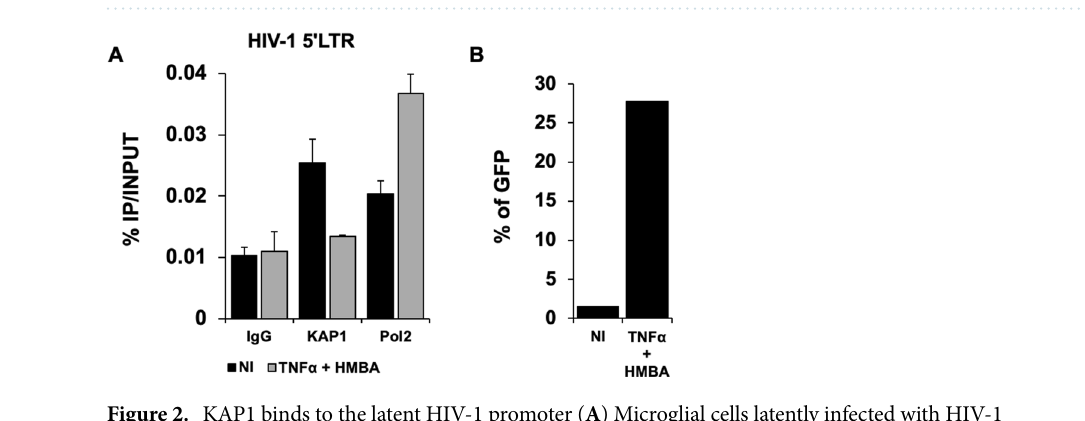
and CTIP2 had a stronger repressive activity on the HIV-1 provirus than overexpressions of each protein alone (Fig. 4A, column 4 versus 2 and 3). Similarly, we observed a modest but significant cooperation in the context of a simultaneous depletion of the two proteins (Fig. 4B, column 4 versus 2 and 3). As shown in Fig. 4C,D, similar results were obtained upon analysis of the activity of 5 ′ LTR viral promoter. To ensure that the effects can be correlated to the expression levels of CTIP2 and KAP1, we performed Western blot analysis. The results demonstrated the efficiencies of the overexpression and the knockdown at the protein level (Figs. 4E,F). Since